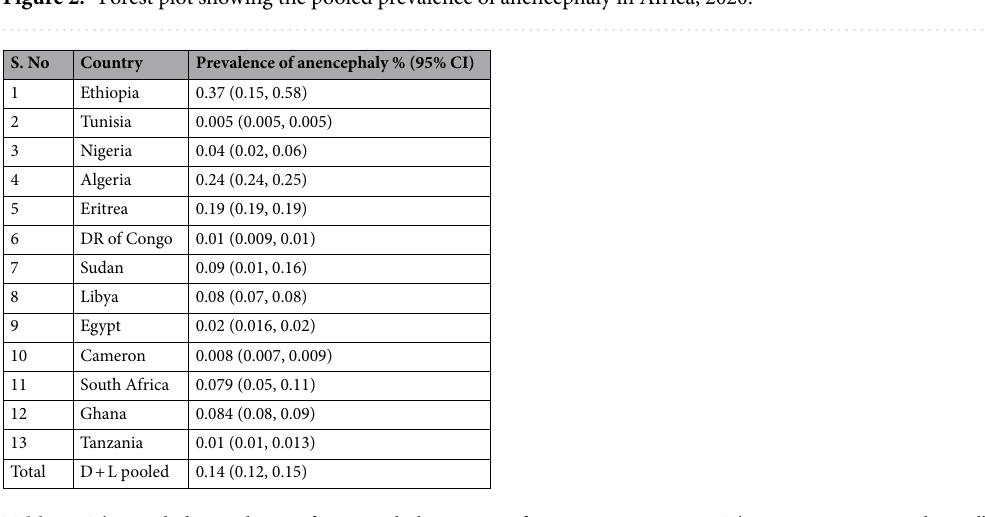
Table 4. The pooled prevalence of anencephaly among African countries, 2020. The Der Simonian and Laird’s (D + L) method was considered for significant heterogeneity between countries ( P < 0.001, I 2 = 99–100%).